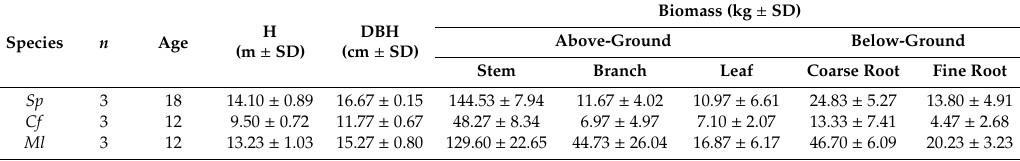
Table 3. Height (m ± SD), DBH (cm ± SD) and biomass data (kg ± SD) of the three tree species from the harvest campaign in November, 2013. The above-ground biomass consists of stem, branch and